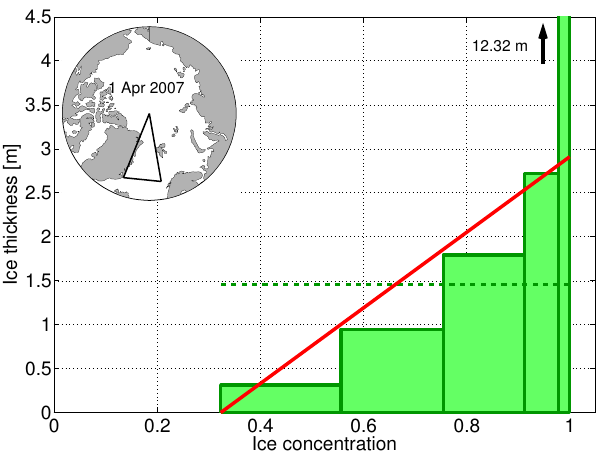
Fig. 6. Sea ice thickness distribution versus ice concentration for LIM3 (green bars) on 1 April 2007, averaged within the black tri- angle shown on the map. The corresponding mean thickness is rep- resented by the dashed green line. The red line represents the ice thickness distribution of LIM2 for the same mean thickness and to- tal